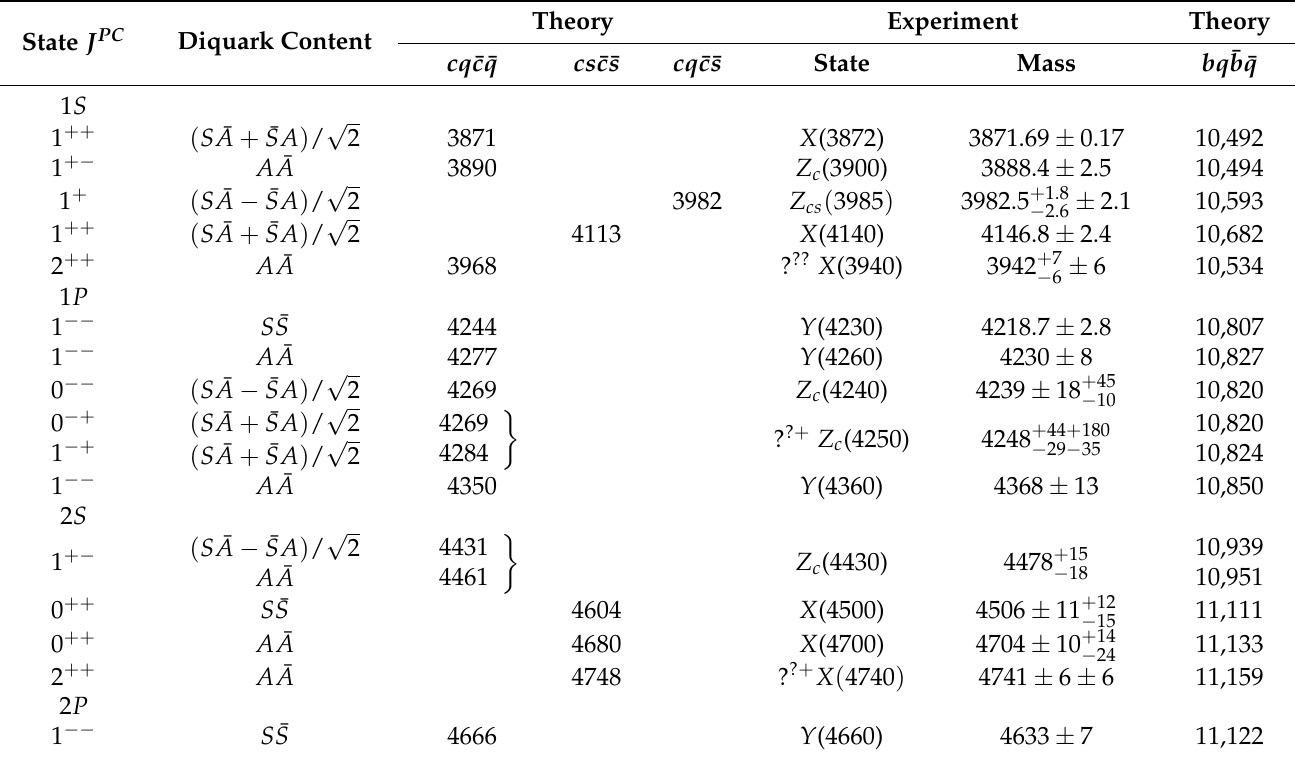
Table 6. Masses of hidden charm diquark–antidiquark states (in MeV) and possible experimental candidates. State J